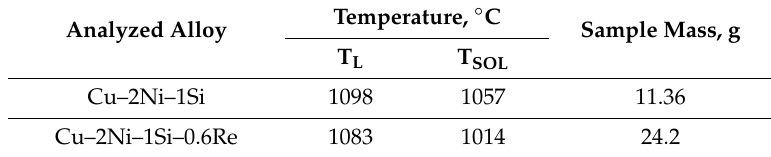
Table 2. Results from thermal-derivative analyses of Cu–Ni–Si–Cr and Cu–Ni–Si–Cr–Re alloys. Analyzed Alloy